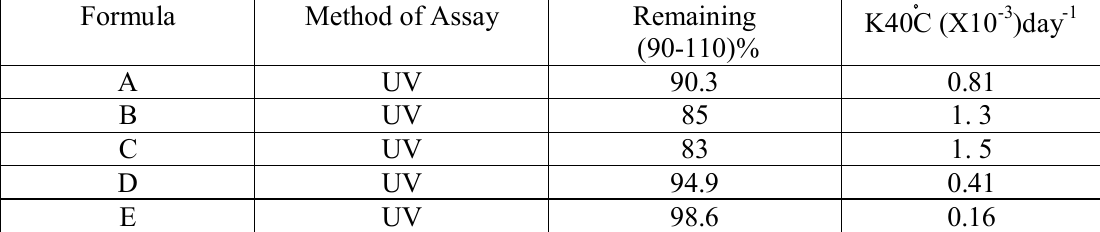
Econazole nitrate in Formulas A, B, C, D and E at 40 o